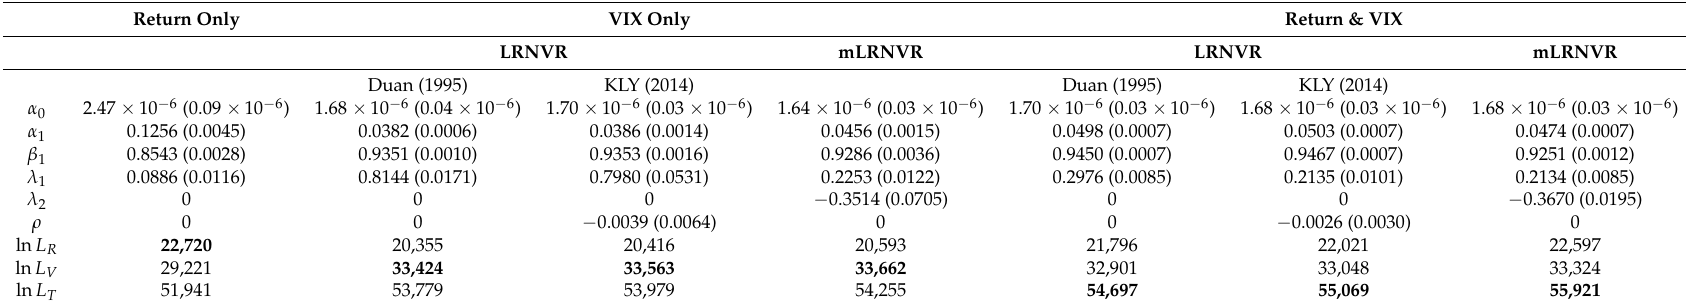
Table 1. Maximum likelihood estimates of the GARCH(1,1) model using returns data only, VIX data only or both returns and Volatility Index (VIX) data. The bold values indicate the log-likelihood value which is being maximized. The standard errors are provided in parentheses. We use a sample of 6928 daily data for the model estimation. Return Only VIX Only Return & VIX